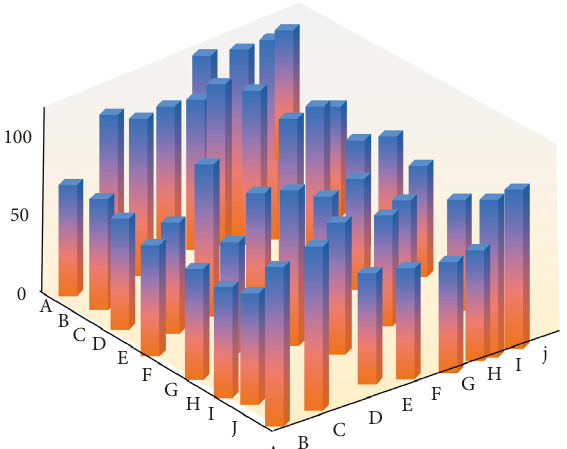
Figure 2: Visualization is based on a two-dimensional